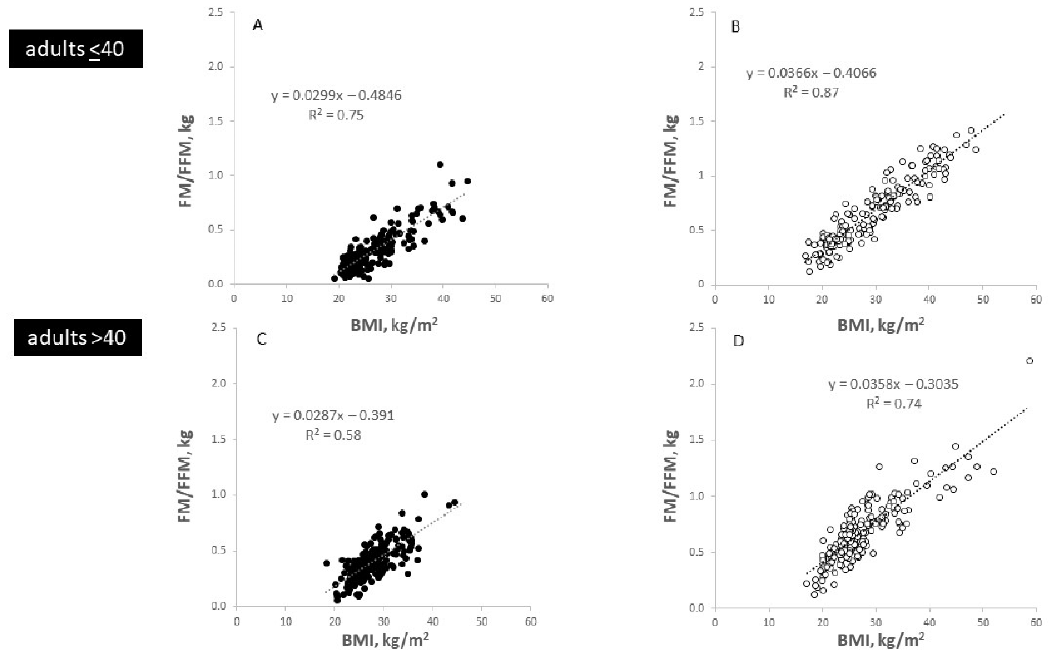
Figure 4. Associations between BMI and the FM/FFM-ratio in males ( A , C ) and females ( B , D ) in adults at age <40 yrs ( A , B ) and >40 yrs ( C , D ). Characteristics of the ‘Kiel study population’: n = 908 subjects; 54% females and 46% males; age range of 18 to 86 yrs with 52% females and 52% males at ≤ 40 yrs of age.